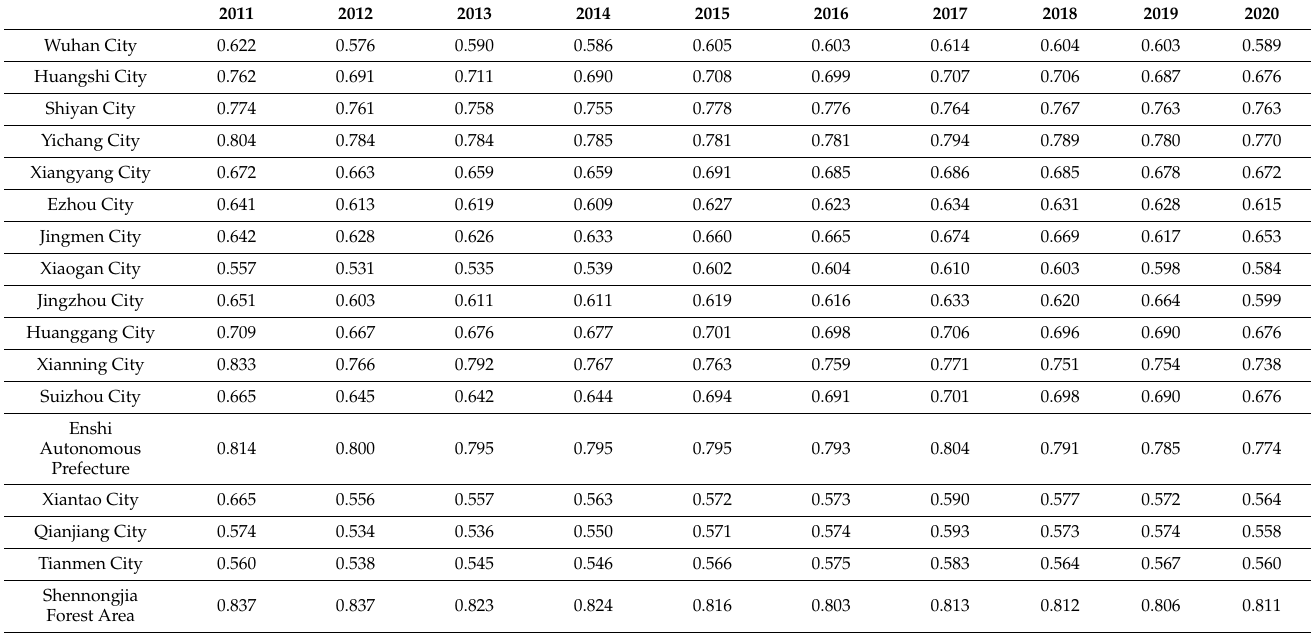
Table 2. Comprehensive water quality coefficients of prefecture-level cities in Hubei Province